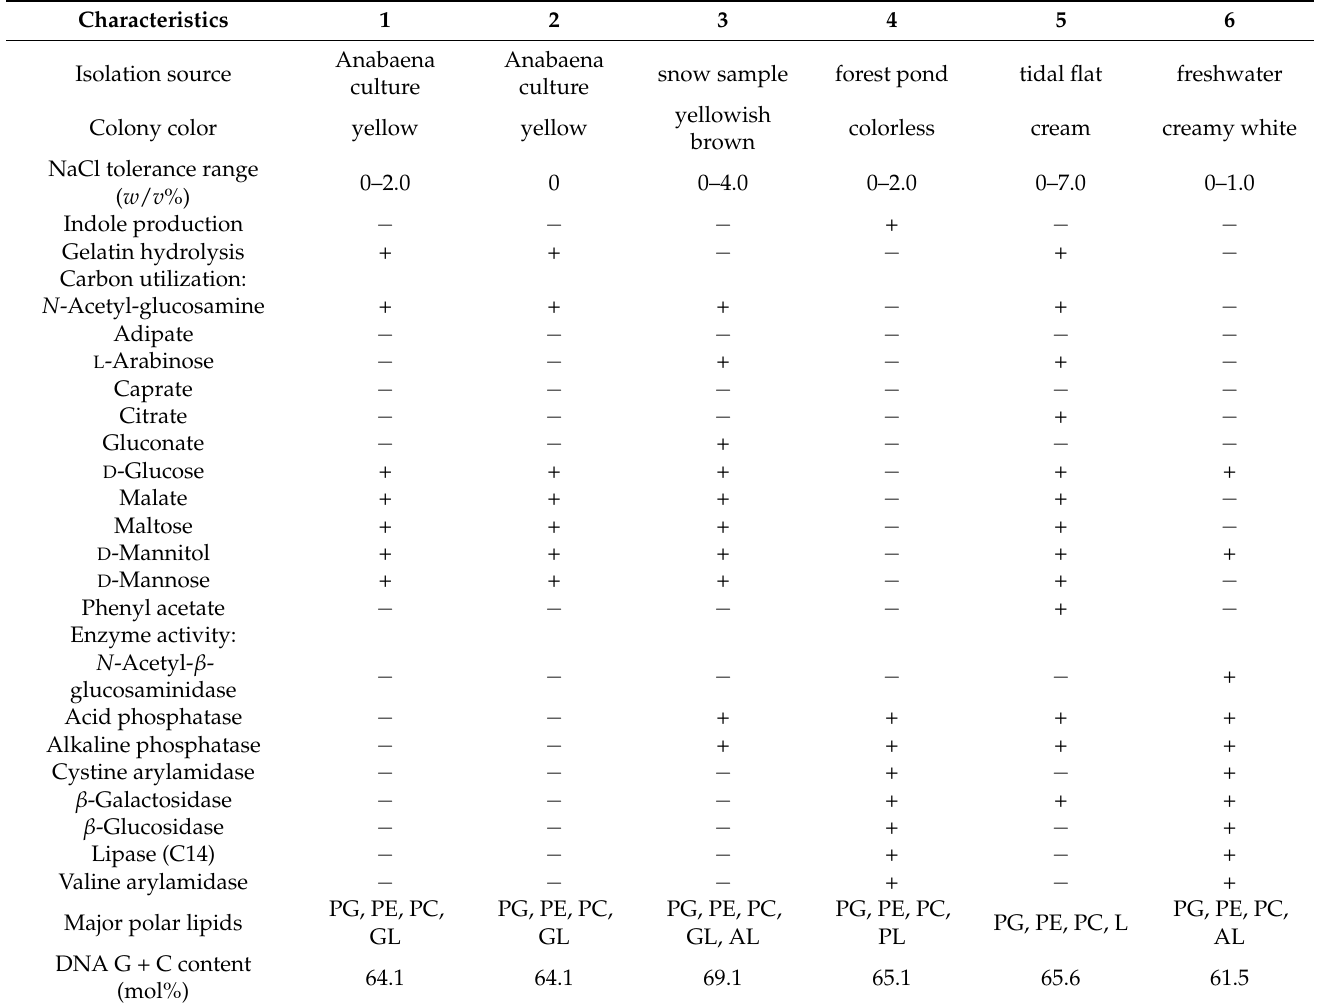
Table 1. Features that differentiate strains con5 T and con4 from type strains of recognized Gemmobacter species: Strains: